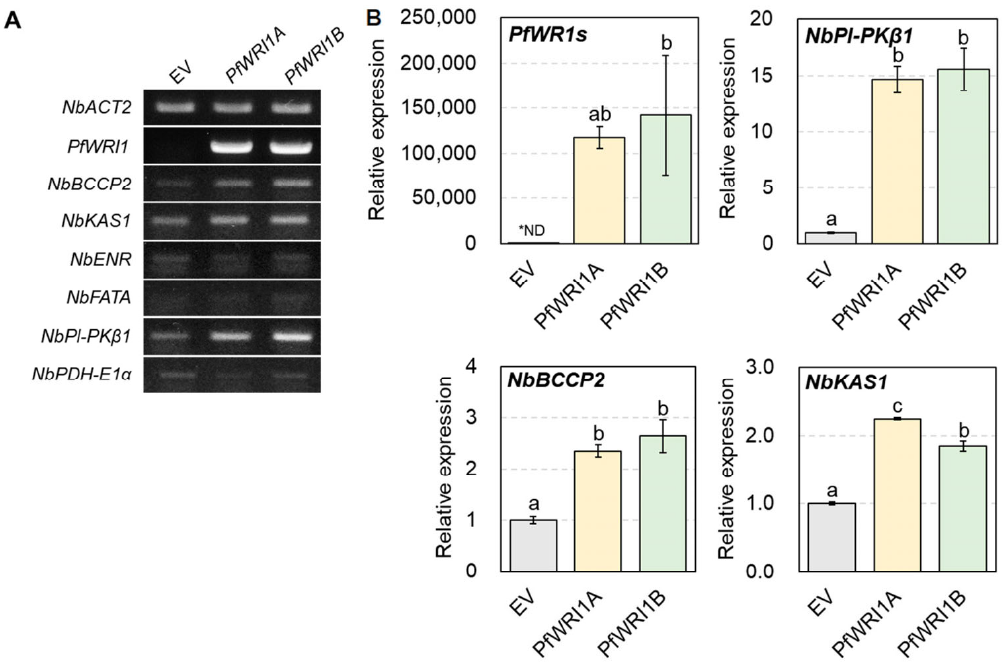
Figure 5. Expression of its target genes in N. benthamiana leaves expressing PfWRI1A or PfWRI1B . ( A ) RT-PCR analysis of its target genes in N. benthamiana leaves expressing PfWRI1A or PfWRI1B. Total RNA was isolated from N. benthamiana leaves expressing PfWRI1A , PfWRI1B , or empty vector control and converted to the cDNA, which was subjected to the RT-PCR analysis. N. benthamiana Actin2 was used to determine cDNA quantity and quality. ( B ) RT-qPCR analysis of its target genes in N. benthamiana leaves expressing PfWRI1A or PfWRI1B. NbActin2 was used to normalize the levels of PfWRI1s and their target genes’ transcripts. Each value is the mean of three independent measurements ± standard error. Data were statistically analyzed using ANOVA test ( p < 0.01). * ND indicates